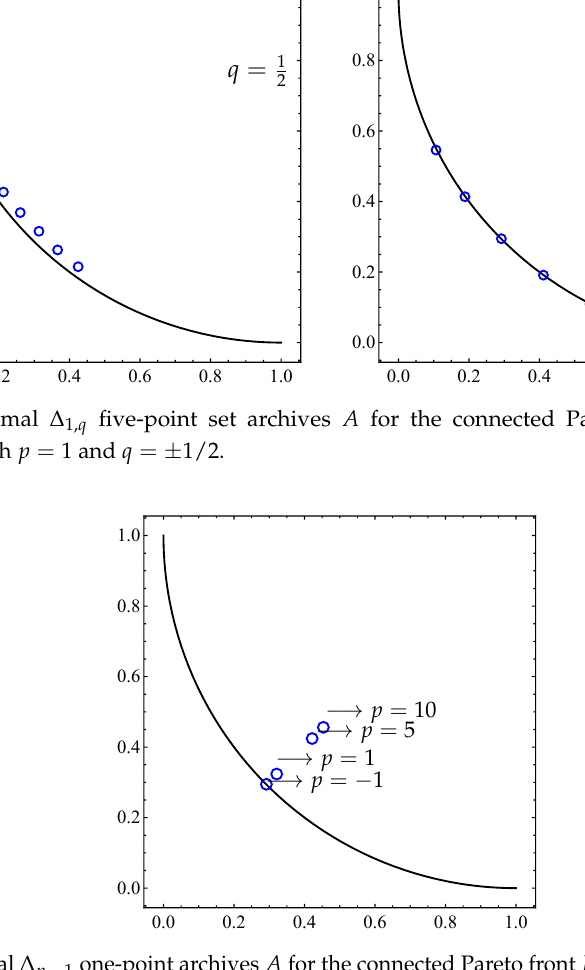
Figure 11. Optimal ∆ p , − 1 one-point archives A for the connected Pareto front P 1 given by Equation (12) with q = − 1 and different values of p : In all cases, the archives are located in the line x = y